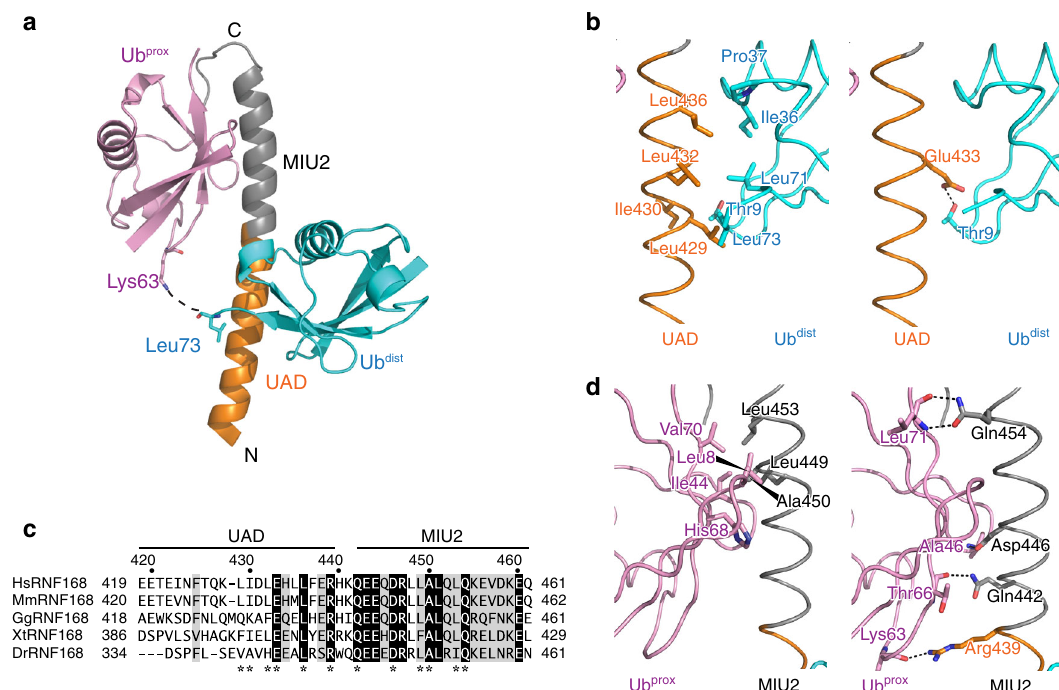
Fig. 3 Structure of the complex between RNF168 UDM2 Δ C and K63-Ub 2 . a Overall structure of the complex. The coloring scheme of UDM2 is the same as in Fig. 1. Ub dist and Ub prox of K63-Ub 2 are colored cyan and pink, respectively. The expected linkage between Ub dist and Ub prox is drawn as a dotted line. b Hydrophobic (left) and hydrogen-bonding (right) interactions between RNF168 UAD and Ub dist . The coloring scheme is the same as in ( a ), c Sequence alignment of UDM2 Δ C in human (Hs), mouse (Mm), chicken (Gg), xenopus (Xt), and zebra fi sh (Dr) RNF168 proteins 56 . The drawing scheme is the same as in Fig. 2d. d Hydrophobic (left) and hydrogen-bonding (right) interactions between RNF168 MIU2 and Ub prox . The coloring scheme is the same as in ( a